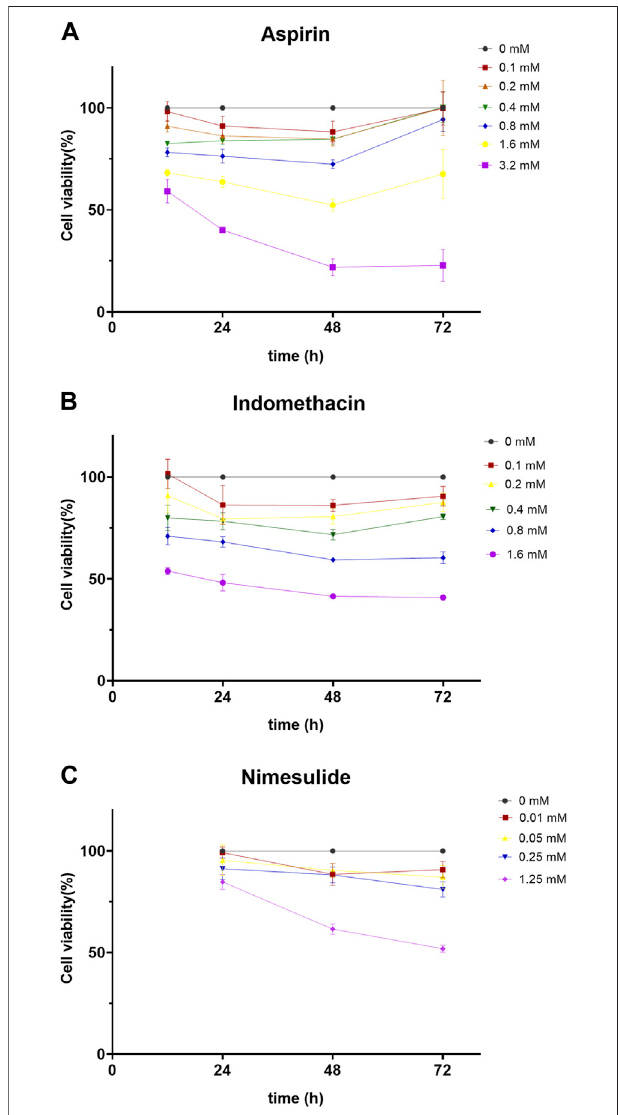
FIGURE 7 | Cell Viability Assay (A,B,C) Aspirin, indomethacin, and nimesulide inhibited cell viability in dose- and time-dependent manner. Cal27 cells were treated with different concentrations of drugs and the viability of these cells was assayed with CCK8 for the indicated